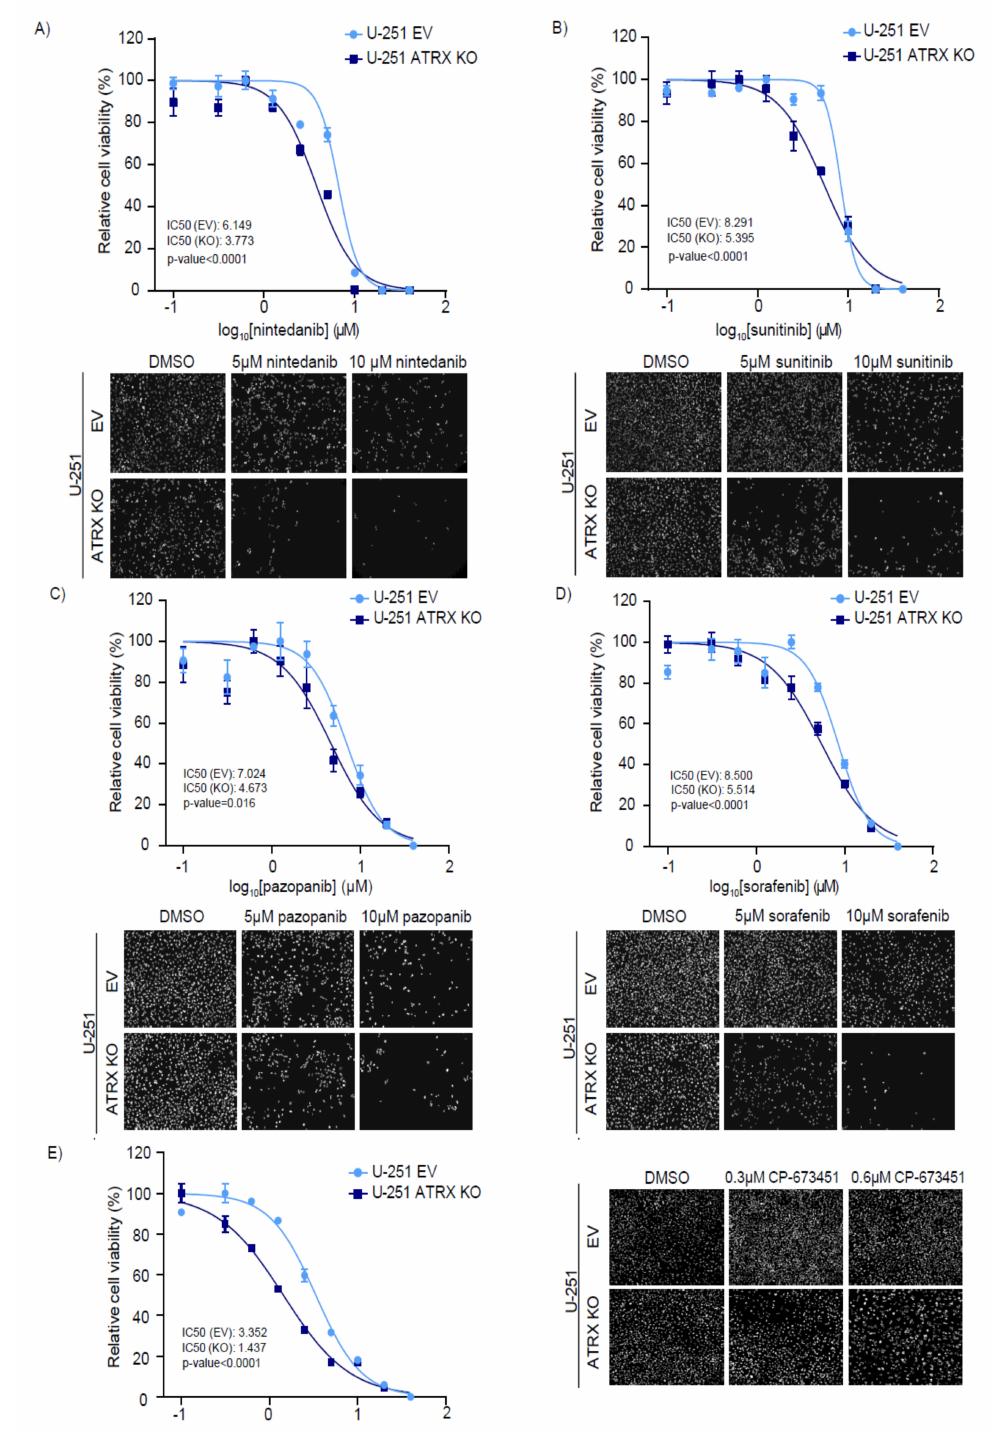
Figure 3. ATRX-deficient high-grade glioma cells are sensitive to multi-targeted RTK and specific PDGFR inhibitors. ( A – E ) Relative cell viability of U-251 (EV and ATRX KO) high-grade glioma cell lines treated with increasing doses of the indicated drug. The IC50 values were calculated from the dose–response curve determined by GraphPad Prism. Data shown correspond to a representative experiment (with technical triplicates) out of three biological replicates. SEMs from each data point are indicated. Significance was assessed by F-test and the p -value for each dataset is shown. Representative images of EV and ATRX KO cells after 48 h of treatment with DMSO or the indicated drug concentrations are